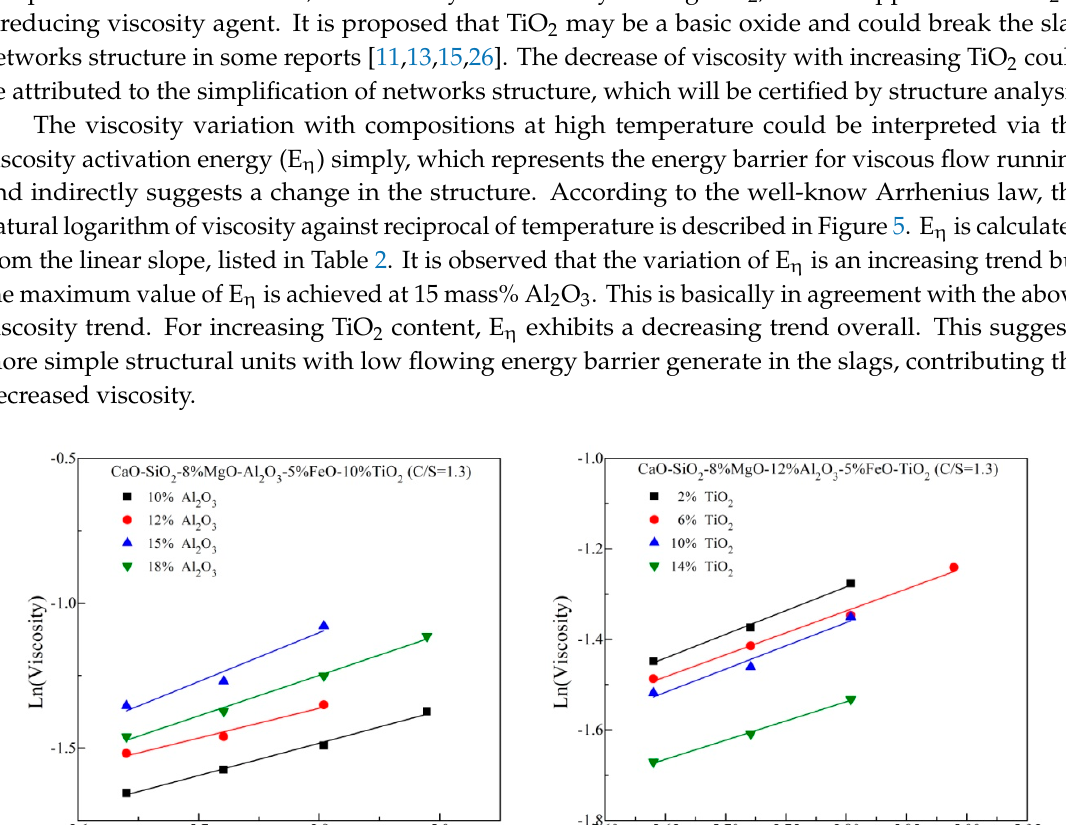
Figure 4. Effects of ( a ) Al 2 O 3 content and ( b ) TiO 2 content on viscosity at various temperatures.